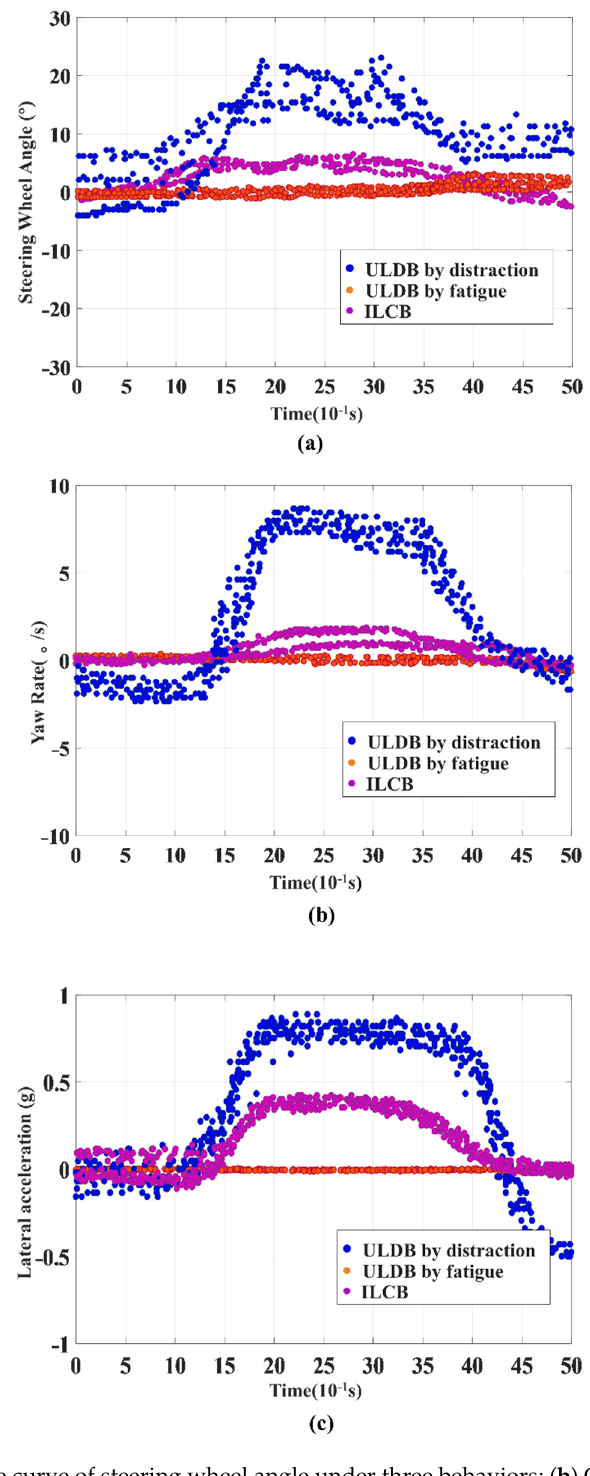
Figure 9. ( a ) Change curve of steering wheel angle under three behaviors; ( b ) Change curve of yaw rate under three behaviors; ( c ) Change curve of lateral acceleration under three behaviors.